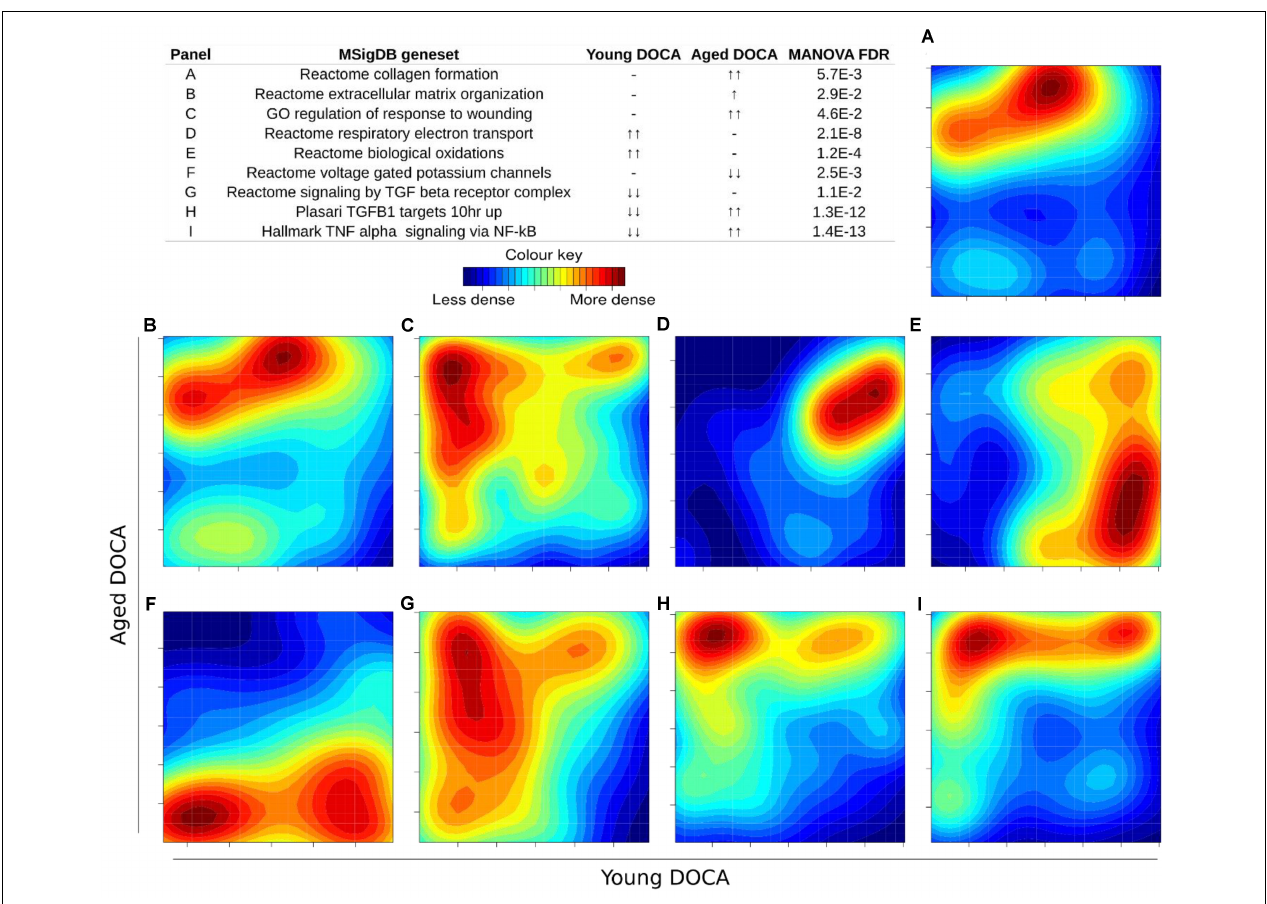
FIGURE 7 | Two-dimensional pathway analysis showing differences between young and aging DOCA mice. Compared to young mice, aging DOCA mice had higher (A) collagen formation, (B) extracellular matrix organization, and (C) wound healing. (D) Both young and aging DOCA mice had activation of the respiratory electron transport chain. (E) Young DOCA mice had activation of oxidation and (F) potassium channels. On the other hand, aging DOCA had higher activation of TGF-beta (G) receptor and (H) targets, and (I) TNF-alpha genes. Sample size: n = 6 young DOCA vs. n = 4 aging DOCA